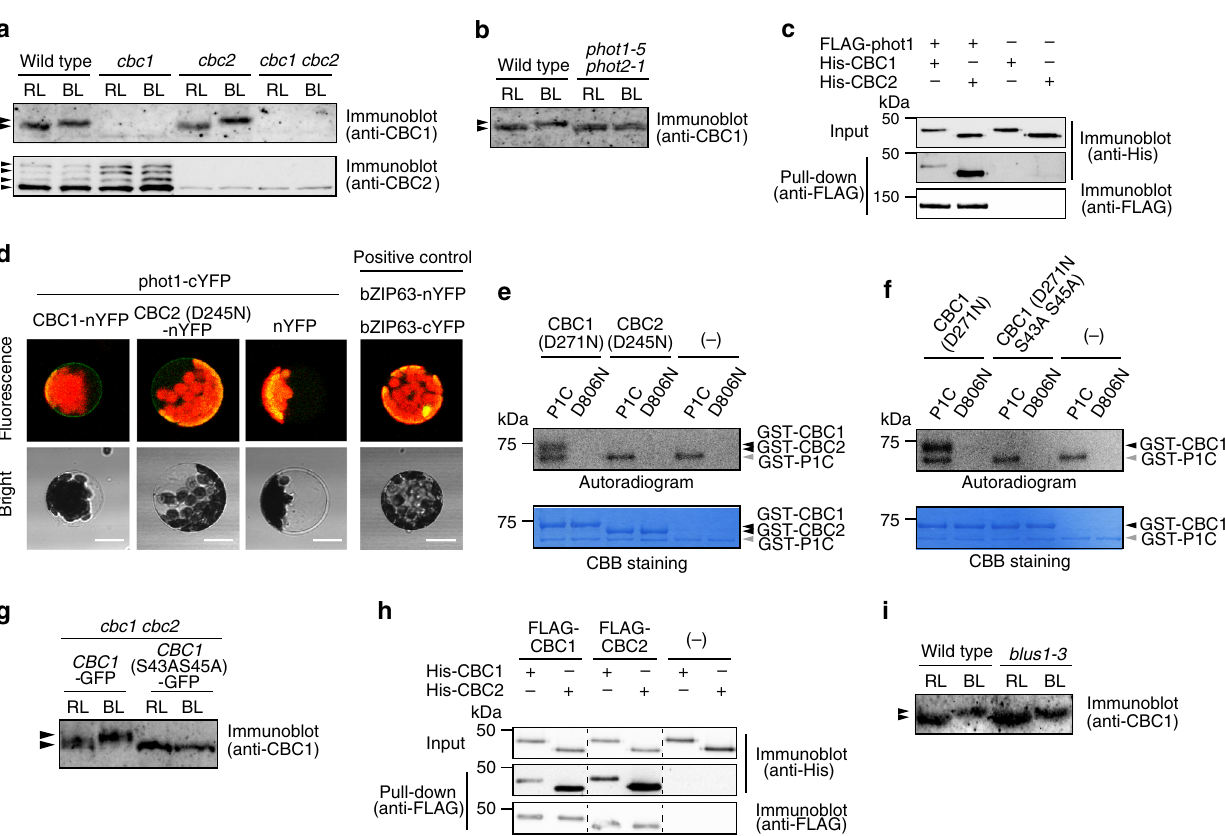
Fig. 4 Phosphorylation of CBC1 by phototropin1 in a BL-dependent manner. a BL-dependent mobility shift of CBC1. GCPs were illuminated with light as described in Fig. 1a. Samples were obtained 1 min after the start of the BL pulse. Immunoblot analysis of CBC1 was performed after electrophoresis on Phos- tag SDS-PAGE that contained 10% acrylamide, 20 μ M Phos-tag, and 40 μ M MnCl 2 . For CBC2, 40 μ M Phos-tag and 80 μ M MnCl 2 were included in the gel. b Phototropin-mediated phosphorylation of CBC1. CBC1 detection was done as described in a . c Pull-down assays of CBC1 and CBC2 by phot1. FLAG-phot1 and His-CBCs were synthesized in vitro transcription/translation. d BiFC assays of CBCs and phot1. CBCs-nYFP and phot1-cYFP were co-transfected to MCPs. White bars represent 20 μ m. e Phosphorylation of kinase-dead CBC1 (D271N) and CBC2 (D245N) by P1C using [ γ - 32 P] ATP. Phosphorylation assays were performed in 30 μ l reaction mixtures that contained 50 mM Tris-HCl (pH 7.5), 10 mM MgCl 2 , 3.3 μ M ATP, 20 μ Ci of [ γ - 32 P] ATP, and puri fi ed proteins. The reactions proceeded for 2 h at 15 °C. GST-tagged P1C or kinase-dead P1C (D806N) were included at 2.5 μ g, and CBC1 (D271N) and CBC2 (D245N) were added at 1.2 μ g. These GST proteins were expressed in E. coli and puri fi ed with glutathione-Sepharose beads. f Phosphorylation of kinase- dead CBC1 (D271N) and CBC1 (D271N S43A S45A) by P1C. Measurement was done as same as e . g Mobility of CBC1-GFP and CBC1 (S43A